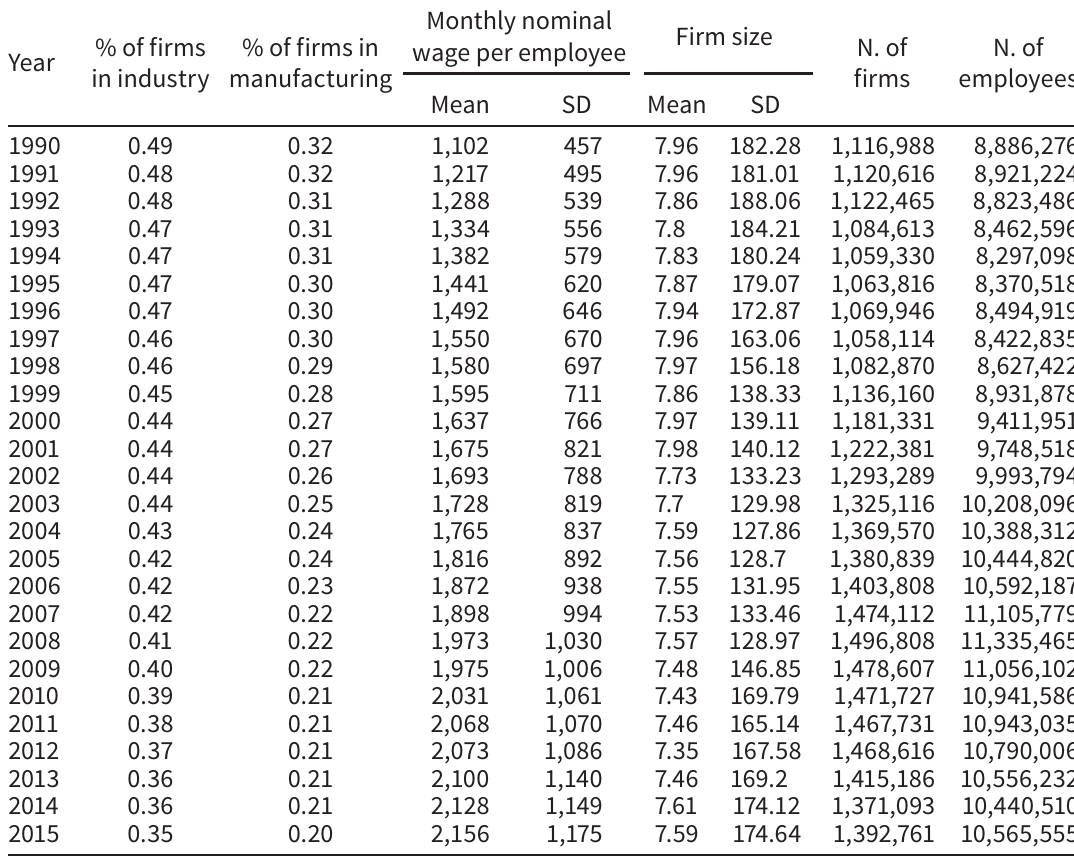
Table A1 Descriptive statistics on universe of firms paying contribution at